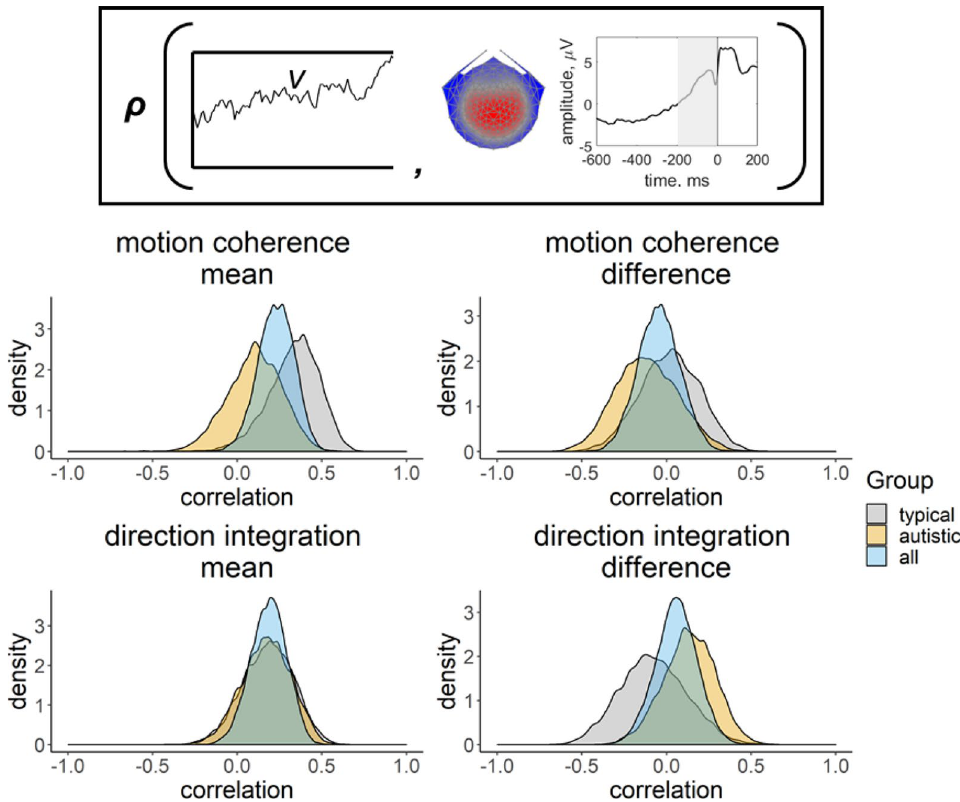
Figure 7. Posterior density plots showing the correlation between drift-rate and the EEG measure. Inset provides a schematic representation of the drift-rate parameter ( v ; left) and EEG measure (slope of response- locked waveform from − 200 to 0 ms around the response; right) that were correlated in the joint model, where ρ represents the correlation. Posterior density plots in the left column reflect the correlation between the mean drift-rate across difficulty levels (v.mean) and the mean EEG slope measure across difficulty levels ( EEG.mean ). Posterior density plots in the right column reflect the correlation between the difference in drift-rate between difficulty levels ( v.diff ) and the difference in EEG slope measure between difficulty levels ( EEG.diff ). Plots for the motion coherence task are presented in the upper row and plots for the direction integration task are presented in the lower row. The blue distribution shows the correlation across all participants, and the grey and orange distributions show separate correlations estimated for typically developing children and autistic children,